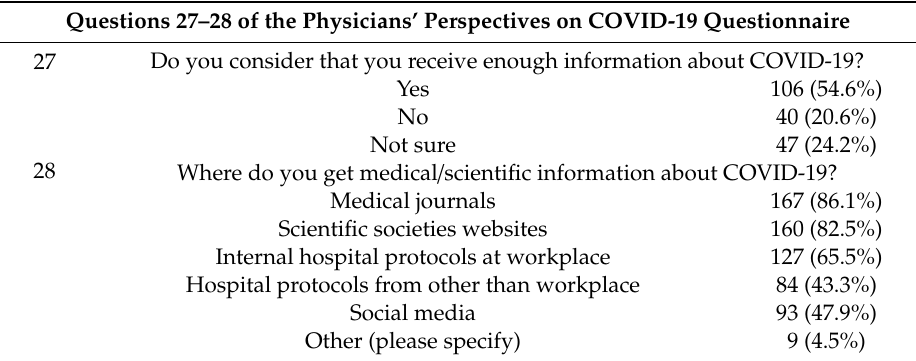
Table 5. Source of medical information and general